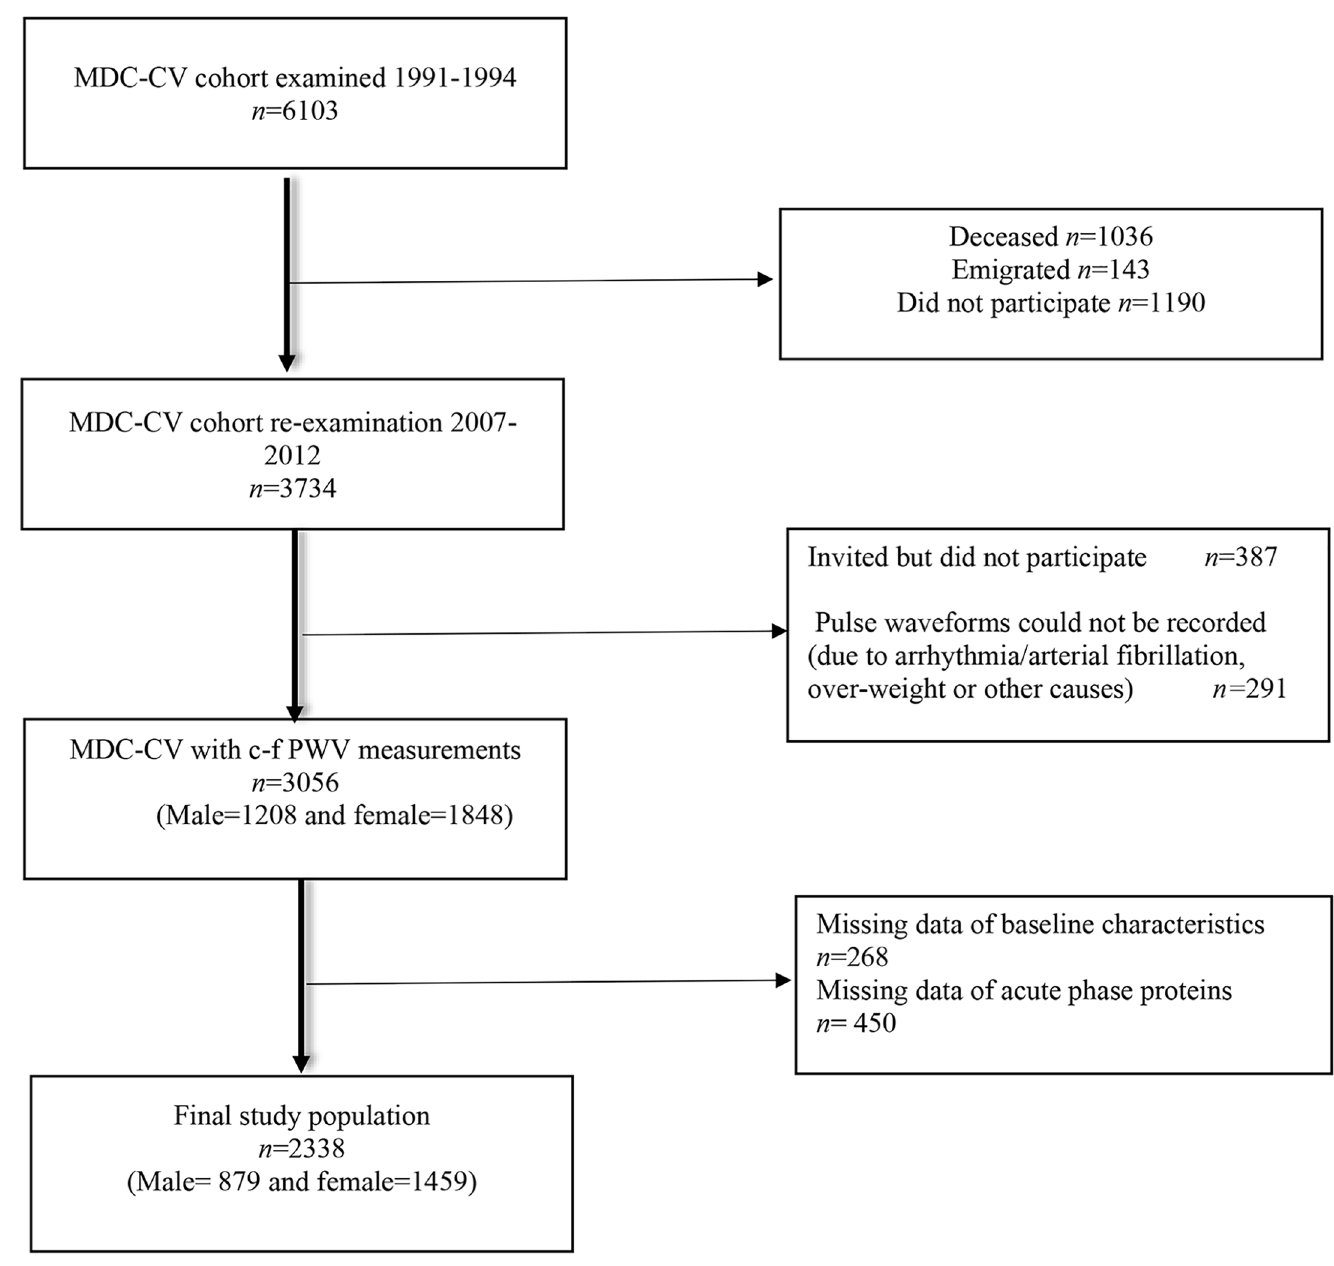
Fig 1. Flow chart of study population ( n = 2338